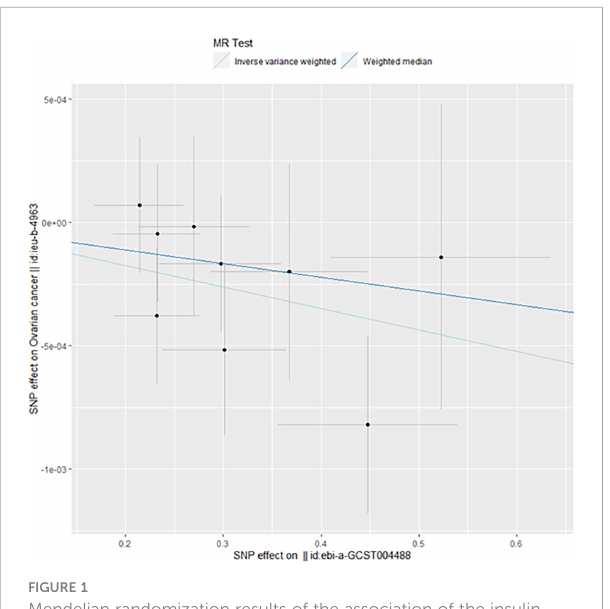
FIGURE 2 The pleiotropy test of MR analysis